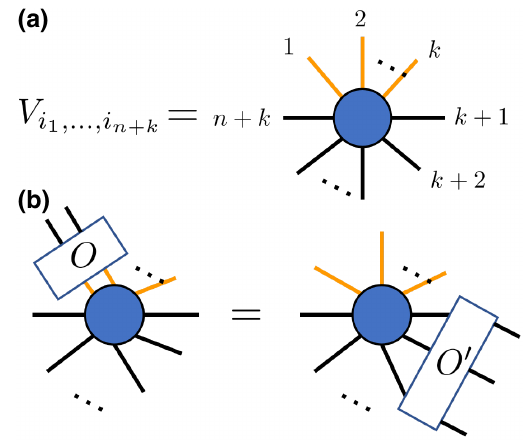
FIG. 1. (a) Graphical representation of a tensor V obtained from an encoding map. We color the “logical” legs orange while the physical legs black. (b) Operator O can be pushed through a tensor to O (cid:6) as long as | V (cid:2) is a + 1 eigenstate of O − 1 ⊗ O (cid:6) (Lemma 4). The same pushing rule also tells us that as a code, O (cid:6) acting on the physical qubits performs a logical operation Q ( O ) defined in Lemma 4 on the encoded qubits. If O = I and O (cid:6)